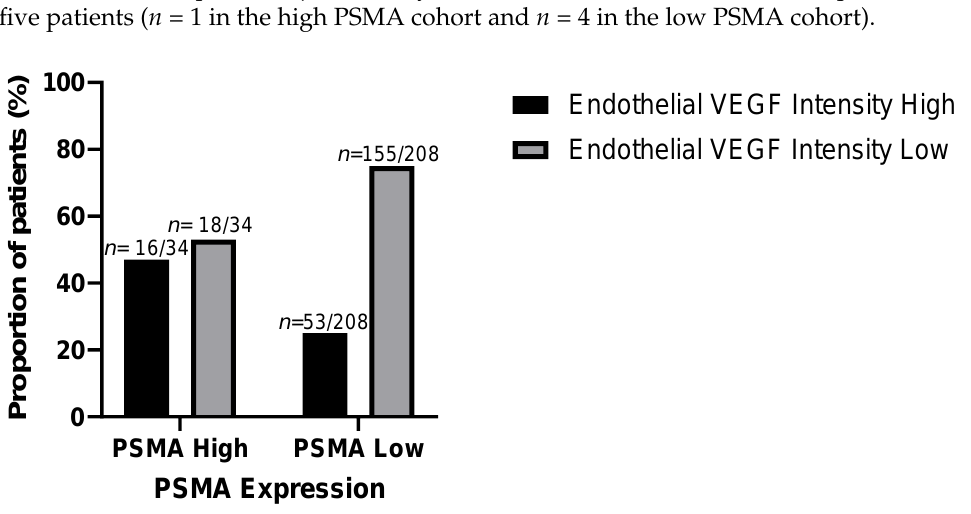
Figure 2. Proportion of VEGF vascular endothelial intensity in PSMA expression high and low groups.